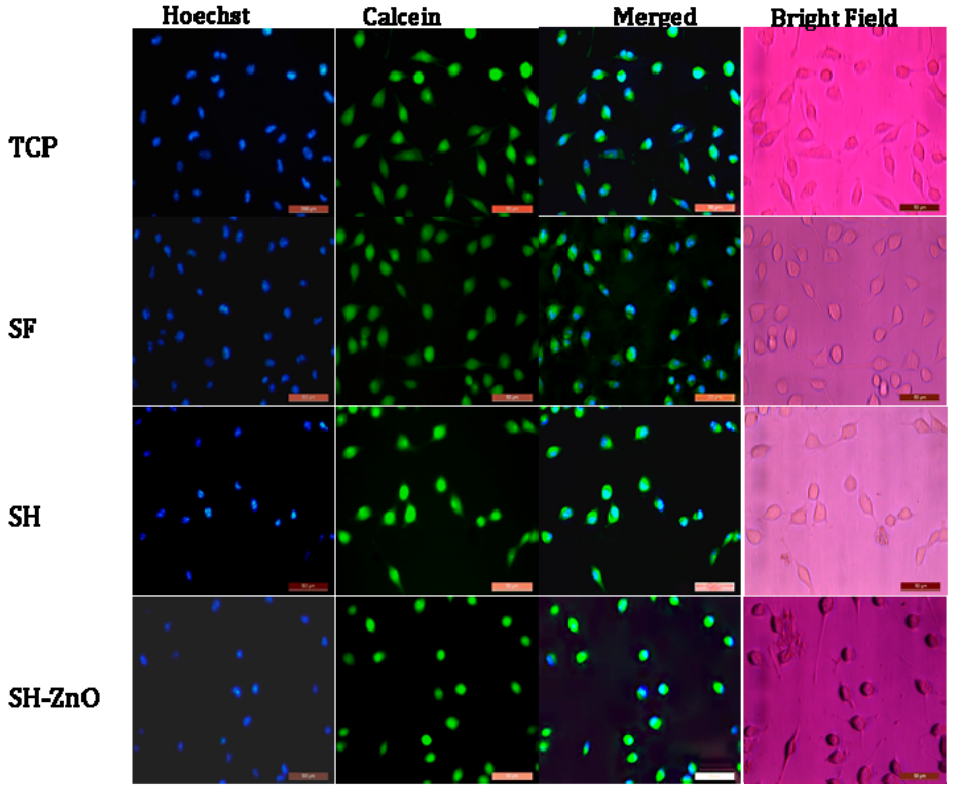
Figure 9. Fluorescence microscopy of cells seeded on di ff erent samples after staining with Holchst and Calcein.